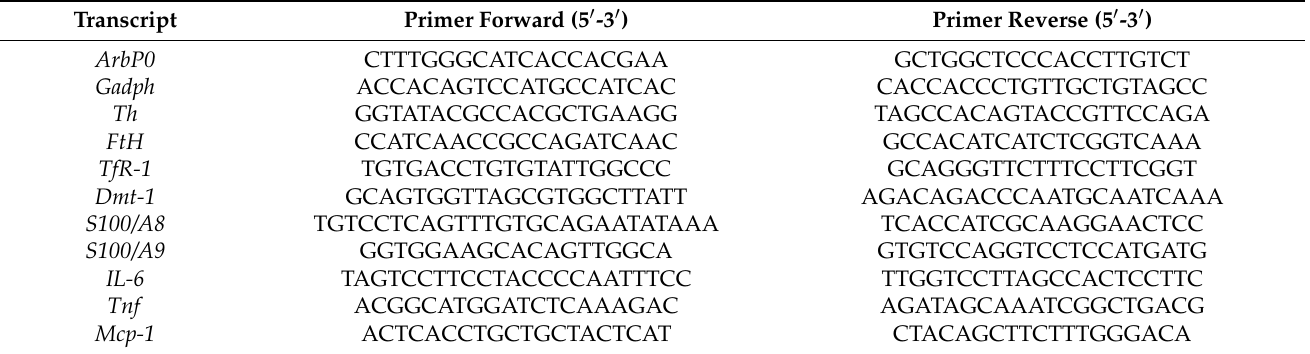
Table 1. List of primer